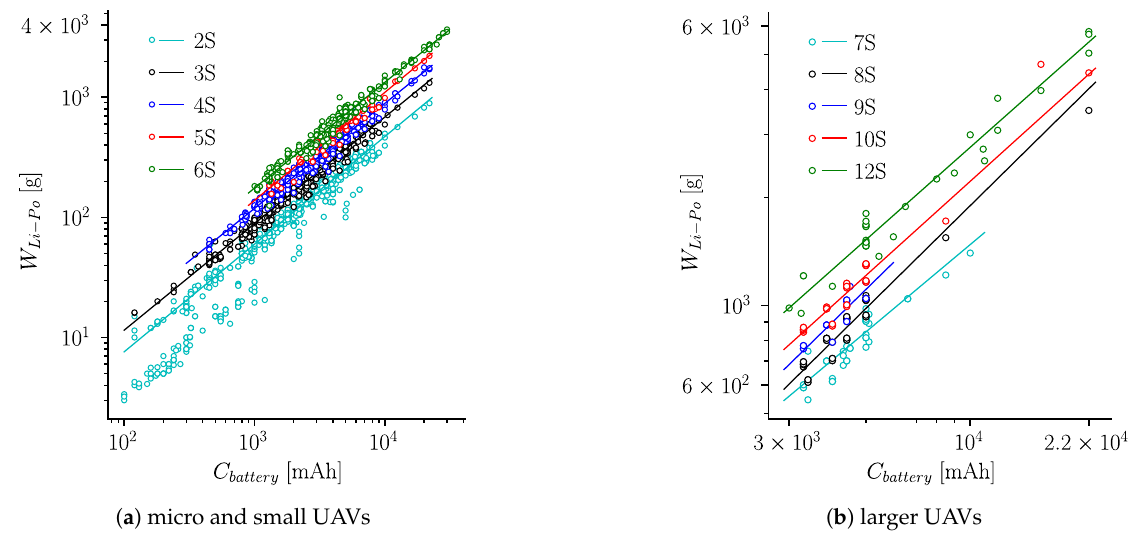
Figure 4. Weight of LiPo batteries ( W Li-Po ) as function of the battery capacity ( C battery )